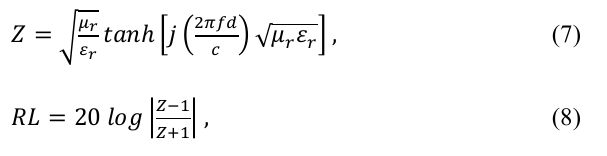
Fig. 9 summarized the attenuation constant and phase constant of all five samples over the x-band frequency.